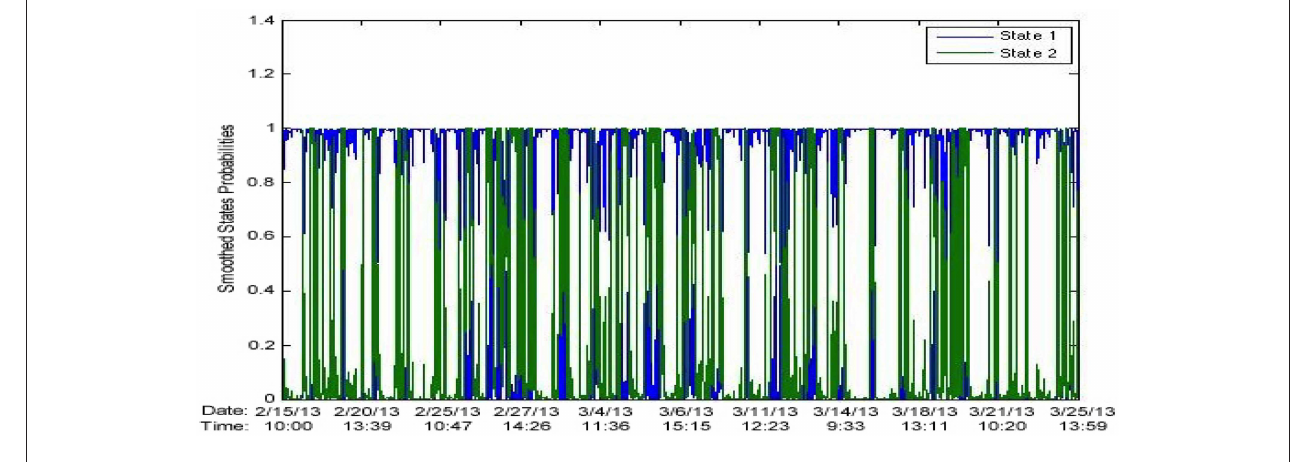
FIGURE 19 | State probabilities over time.